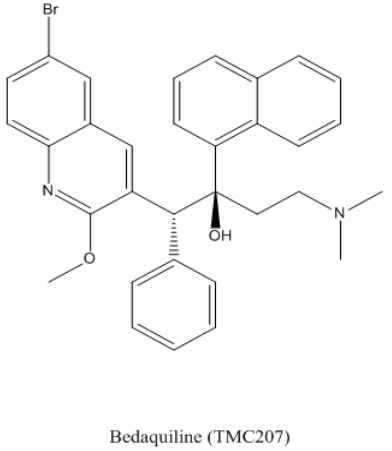
Figure 1. Structure of bedaquiline.